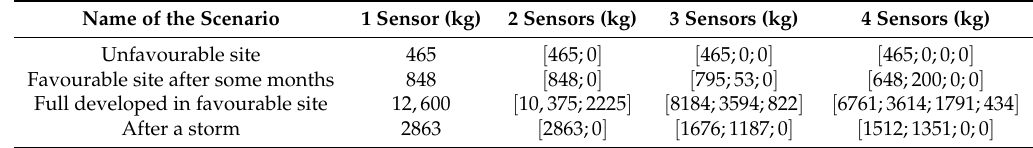
Table 5. Mass distribution of each reference scenario of